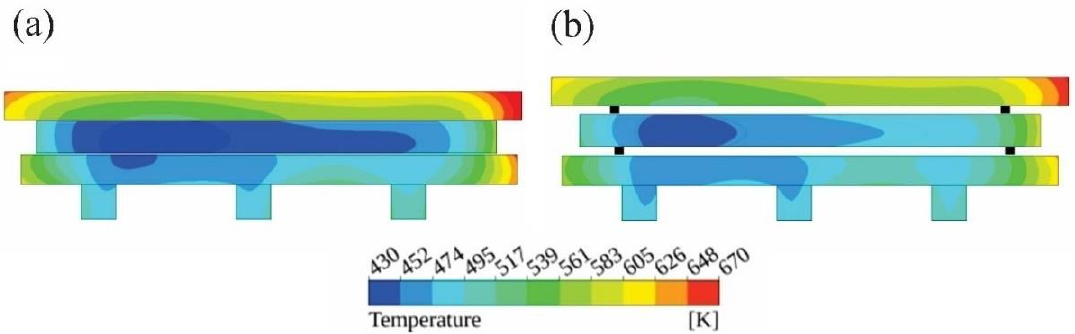
Figure 10. Temperature distribution at the central cross-section of ( a ) Config-2-S0 and ( b ) Config-2- S5.